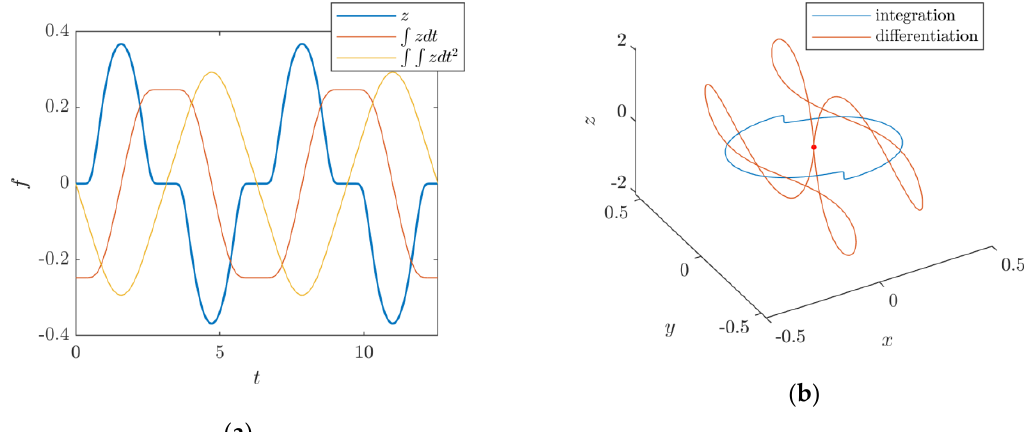
Figure 3. Example of phase space reconstruction. ( a ) Time series z and its two integrals; ( b ) comparison of an integration-based approach (blue trajectory) and a differentiation-based approach (red trajectory). The red dot at x 0 = ( 0,0,0 ) T denotes a singular point unresolvable in sense of FNN where the uniqueness condition is violated.